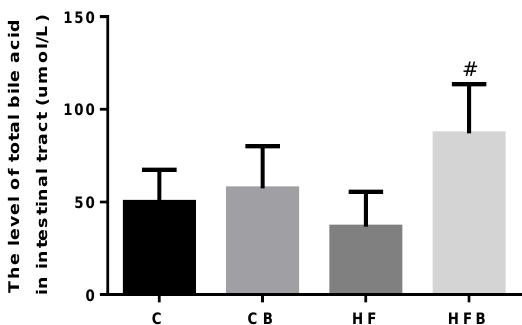
Figure 10. Effects of betaine and high-fat diet on total bile acid in intestine of rats ( n = 8). Two-way ANOVA: BET, p = 0.041, FAT, p = 0.211, interaction, p = 0.143. C—basal diet, CB—basal diet